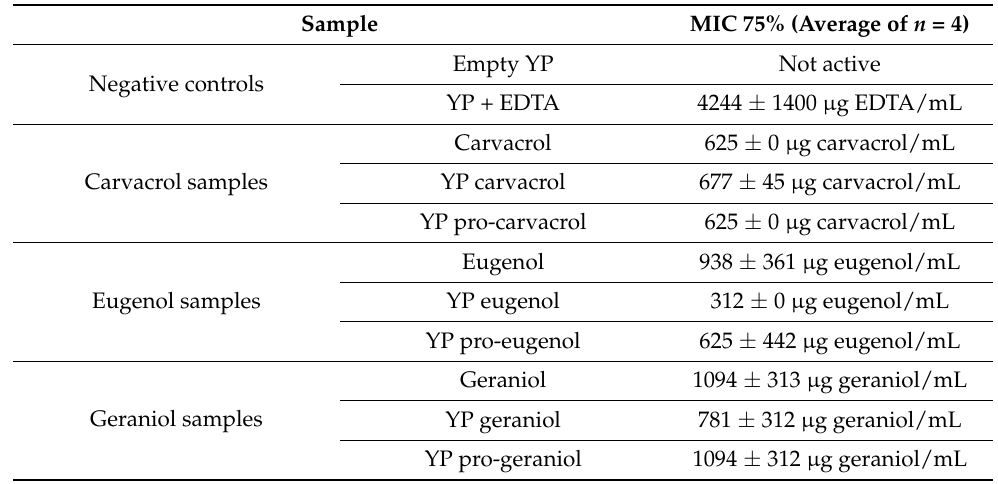
Table 2. In vitro antibacterial activity on E. coli of free terpene, YP terpene and YP pro-terpene samples.